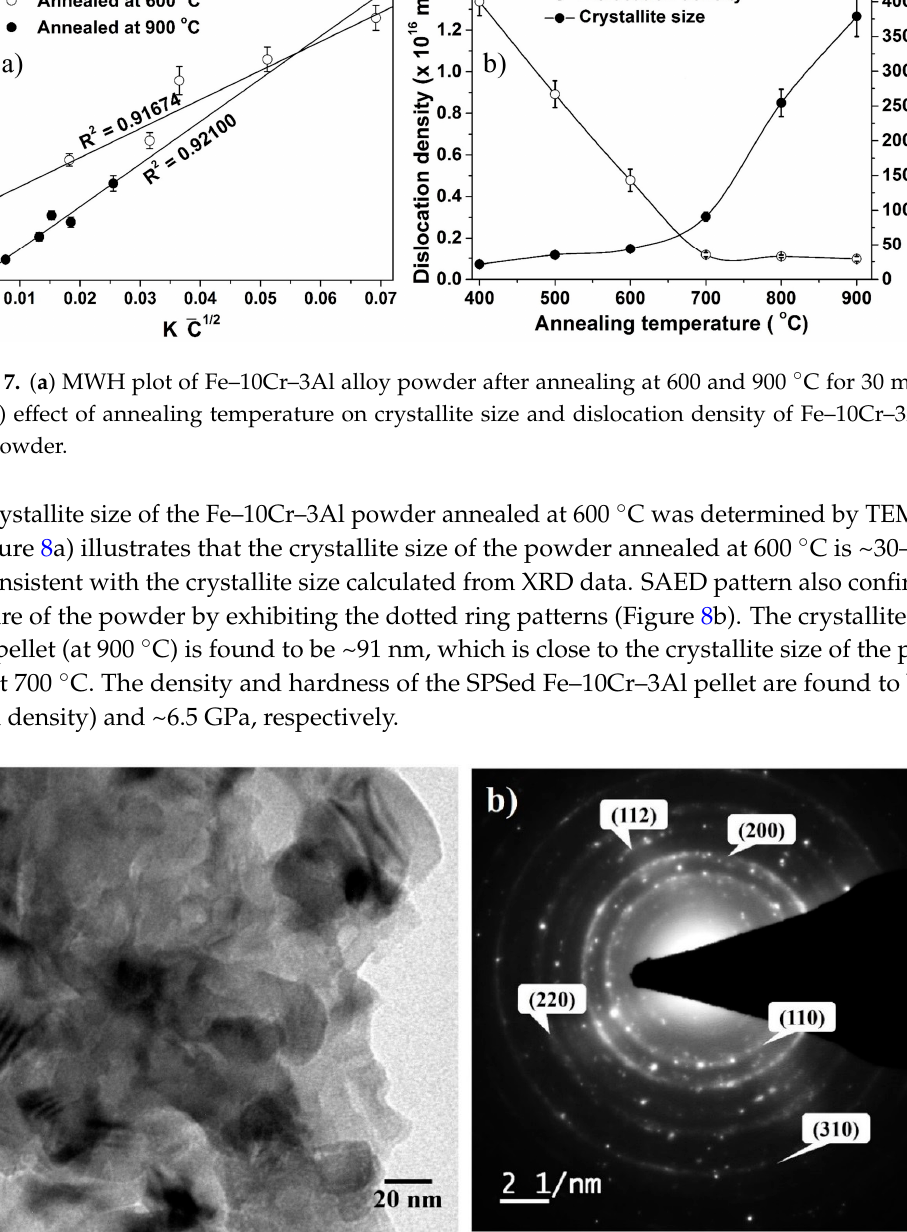
Figure 8. ( a ) TEM image and ( b ) SAED of Fe–10Cr–3Al alloy powder annealed at 600 °C for 30 min.